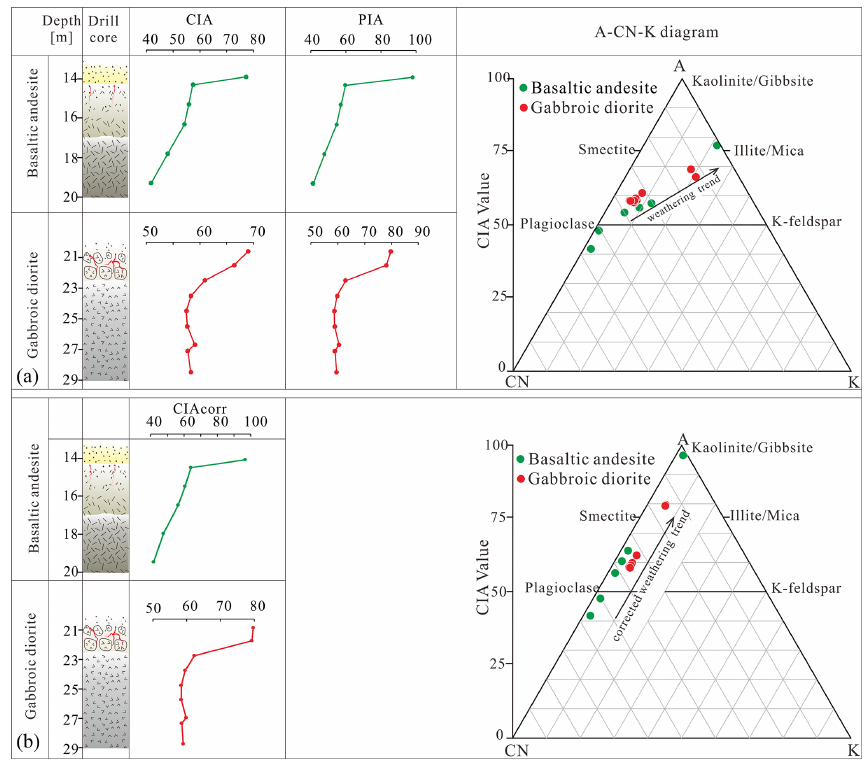
Figure 8. Weathering indices with an A–CN–K diagram of both basaltic andesite and gabbroic diorite before and after K correction, based on Fedo et al. (1995) and Nesbitt and Markovics